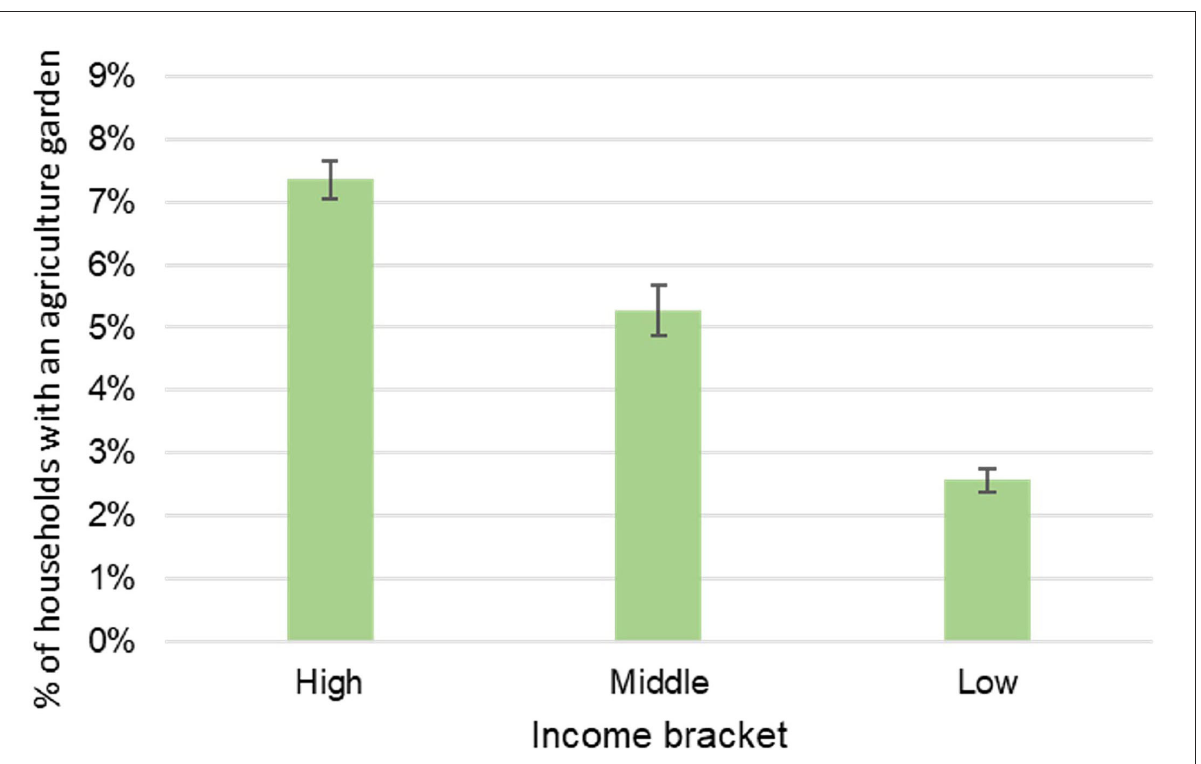
FIGURE2 Frequency of households with an agriculture garden across three income brackets (high, middle, low) in the Twin Cities. Error bars represent the 95% confidence interval of the